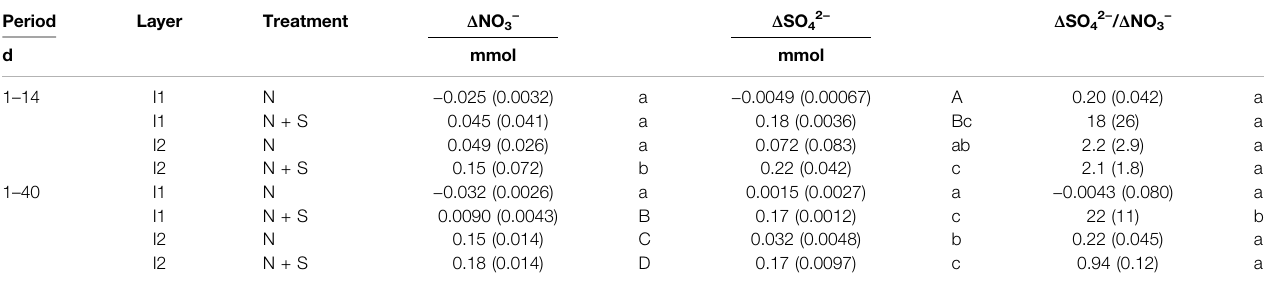
Different letters indicate signi fi cant differences detected using One-way ANOVA followed by Bonferroni ’ s test ( p < 0.05).